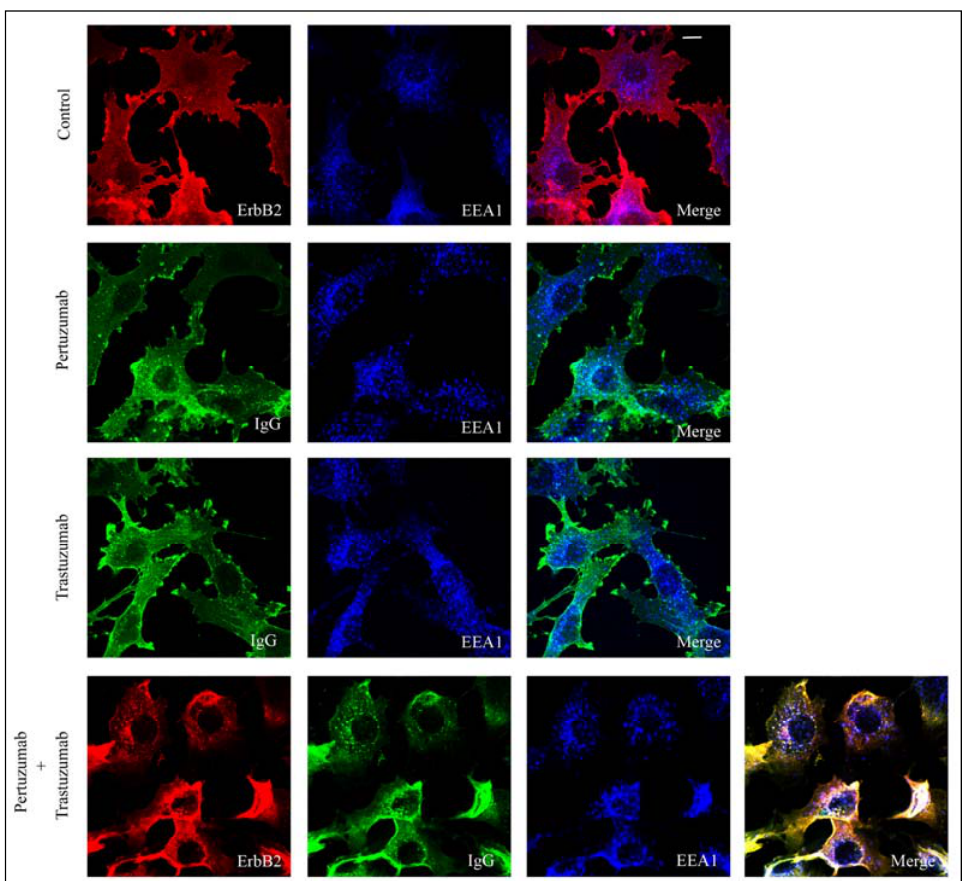
to varying extent in dedifferentiated cells. Such cell differences could explain some of the previously reported contradictory results with respect to effect of trastuzumab on ErbB2 down-regulation [34]. Figure 1. The combination of pertuzumab and trastuzumab enhances antibody-induced endocytosis of ErbB2. PAE.ErbB2 cells were incubated without antibodies (Control), or with pertuzumab only, trastuzumab only, or pertuzumab and trastuzumab in combination for 1 h at 37 °C. The cells were fixed, permeabilized, and immunostained. Cells not incubated with antibodies (Control) were stained using mouse anti-ErbB2, and goat anti-EEA1 antibodies followed by Rhodamine-conjugated donkey anti-mouse, and Alexa647-conjugated donkey anti-goat antibodies. Cells treated with pertuzumab or trastuzumab only were stained using Cy2-conjugated donkey anti-human and goat anti-EEA1 antibodies followed by Alexa647-conjugated donkey anti-goat antibodies. Cells treated with pertuzumab and trastuzumab in combination were stained using Cy2-conjugated donkey anti-human, mouse anti-ErbB2, and goat anti-EEA1 antibodies followed by Rhodamine-conjugated donkey anti-mouse and Alexa647-conjugated donkey anti-goat antibodies. The cells were analyzed by confocal microscopy. Both pertuzumab and trastuzumab are observed in EEA1 positive early endosomes (middle panels, white dots). In cells treated with pertuzumab and trastuzumab, ErbB2 colocalizes with the antibodies in EEA1 positive early endosomes, confirming that ErbB2 was endocytosed (lower panel, white dots). The figure shows one representative experiment out of three independent experiments. Bar, 10